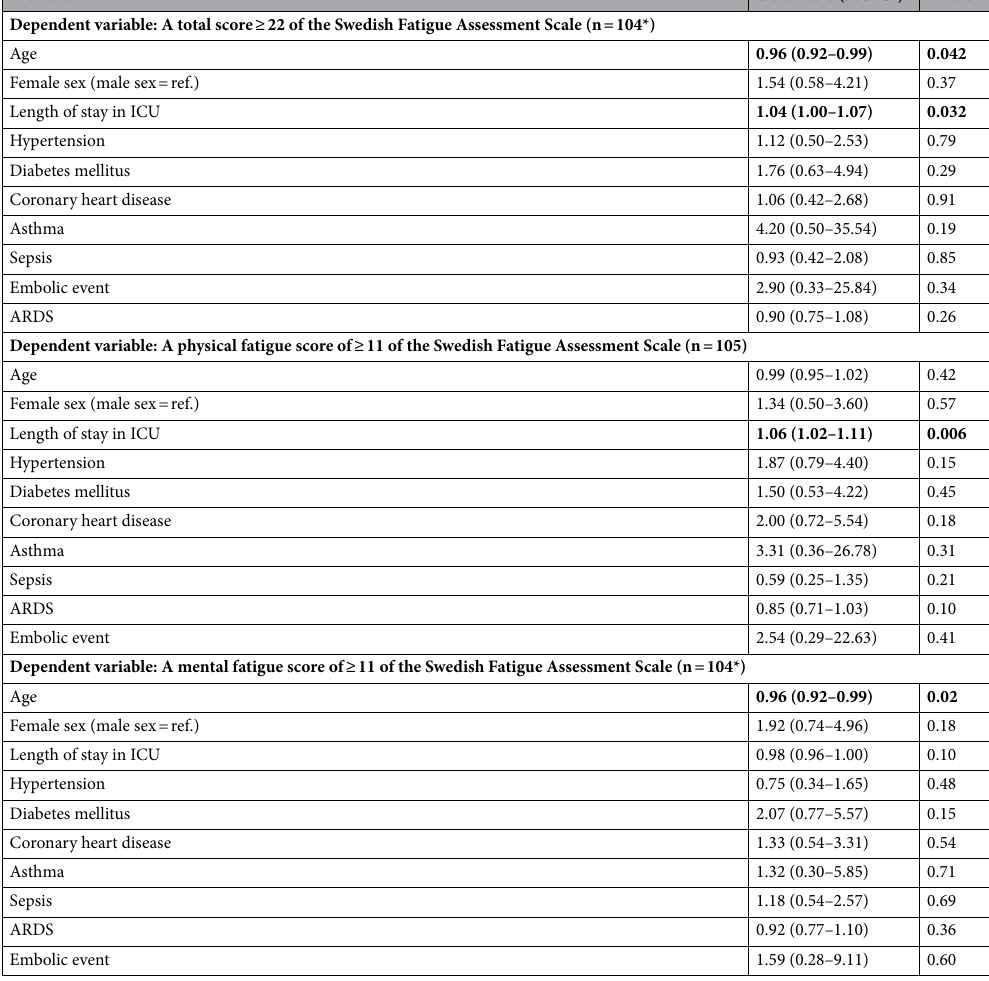
Table 3. Univariable analyses for prediction of fatigue in ICU-admitted individuals at one year after COVID- 19. CI confidence interval, ICU intensive care unit, ARDS acute respiratory distress syndrome. *Interval estimation failed to calculate the dichotomized S-FAS total score for one of the 105 participants. Significant values are given in